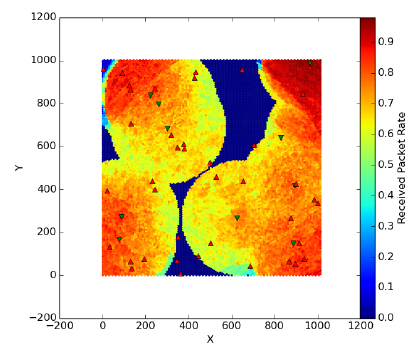
Figure 9. RPR with 40 noise nodes at h =60m